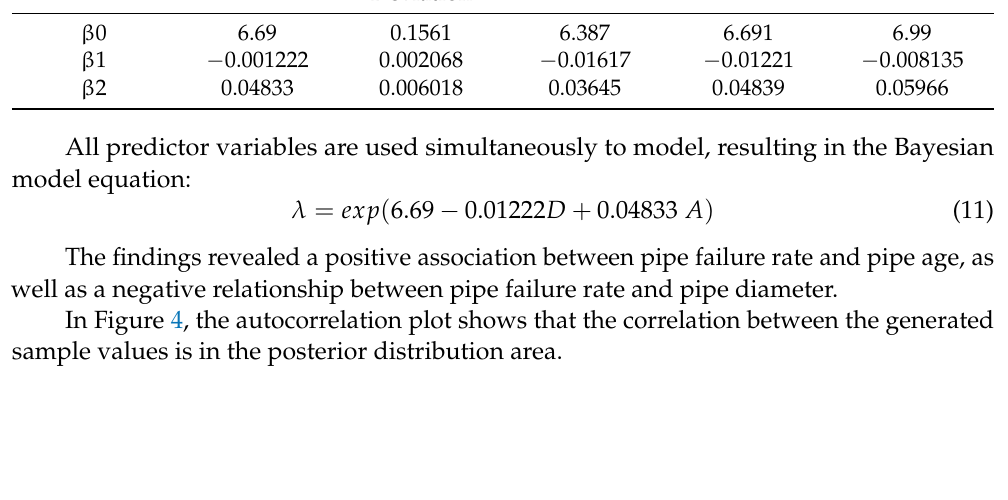
Figure 3. Directed acyclic graph (DAG).